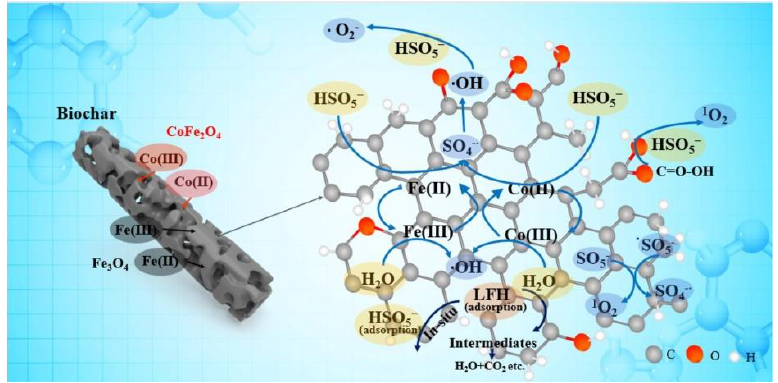
Figure 3. Possible mechanism of magnetic biochar/CoFe 2 O 4 /PMS system for lomefloxacin hydrochloride degradation. Reprinted with permission from ref [80]. Copyright 2021 Elsevier B.V.